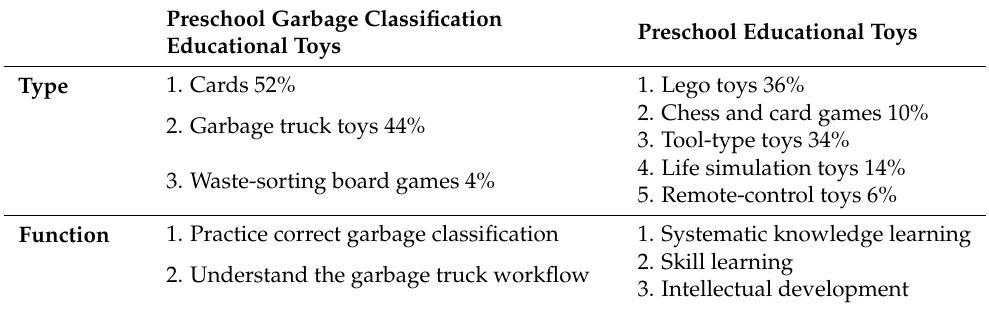
Table 1. Type and function comparison of preschool garbage classification educational toys and preschool educational toys.